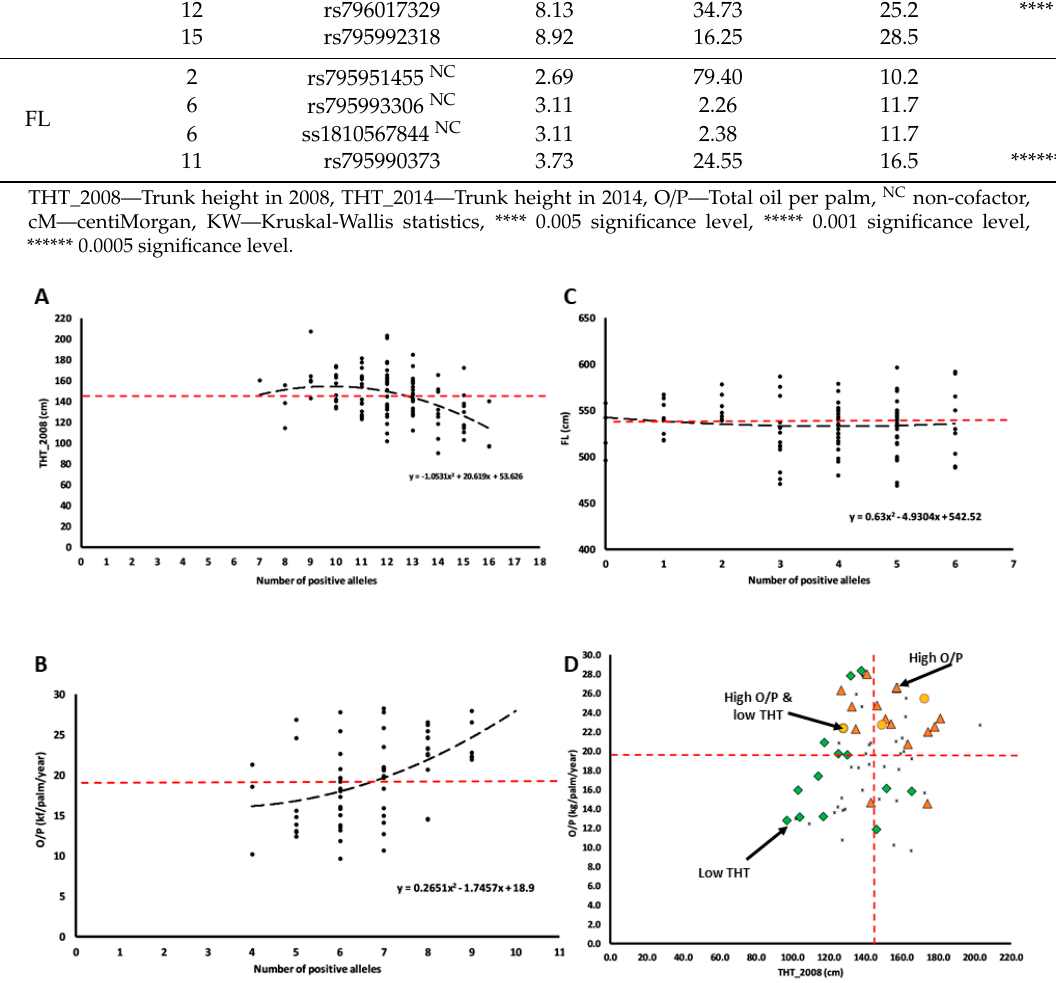
Figure 3. Cumulative e ff ects of quantitative trait alleles for ( A ) THT_2008, ( B ) O / P, ( C ) FL traits, and ( D ) the application for selection of THT_2008 and O / P traits in the GM-3341 Family. Red dotted line—mean THT_2008 (145.07 cm), mean O / P (19.50 kg / palm / year) and mean FL (534.53 cm); orange dot—High O / P and low THT_2008, red triangle—High O / P, green diamond—Low THT_2008; multiple trait selection in Figure 3D based on threshold numbers of positive alleles for THT_2008 = 13 and for O / P = 7.